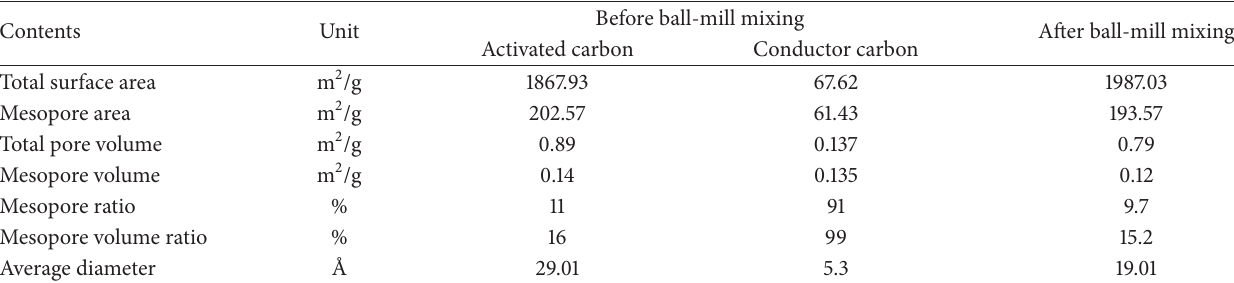
Table 1: BET data of the active materials for the electrodes before and after ball-mill